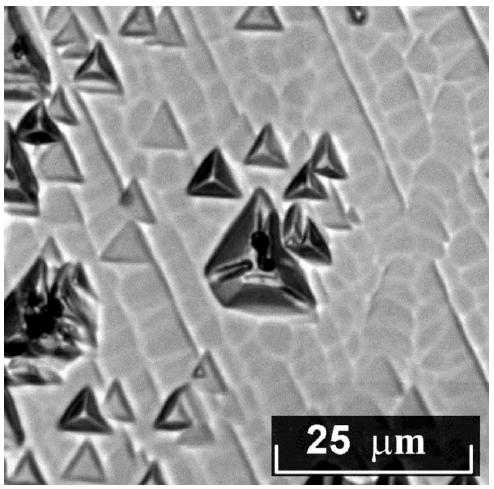
Figure A9. Accumulation of triangular domains against the background of an uneven mosaic structure in a LiNbO 3 :Mg crystal (joint solid-phase synthesis, [MgO] ≈ 4.7 mol% in the crystal), Z- cut.